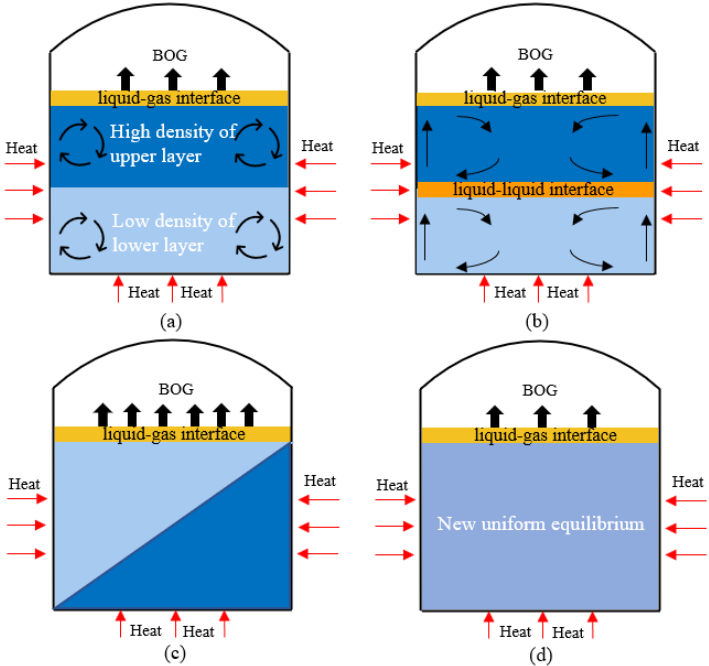
Figure 1. LNG stratification and rollover mechanism in the storage tank. ( a ) LNG stratification; ( b ) LNG interlayer penetration; ( c ) LNG rollover; ( d ) the new uniform equilibrium in temperature and density. This figure is adapted from